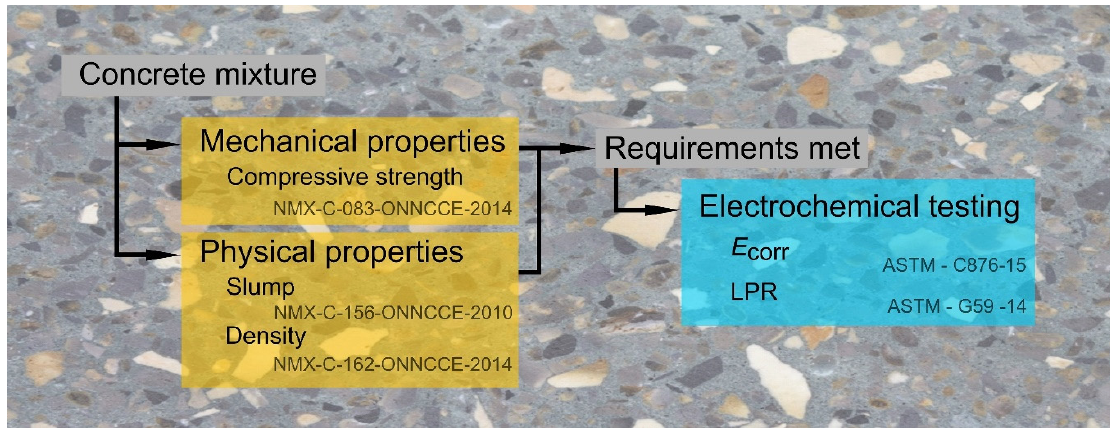
Figure 1. Experimental testing procedure schematic.